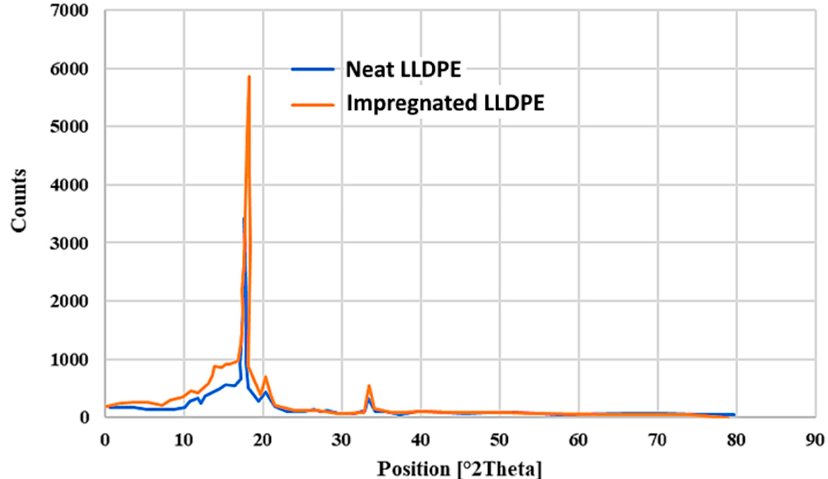
Figure 9. XRD patterns of the neat and impregnated LLDPE films.